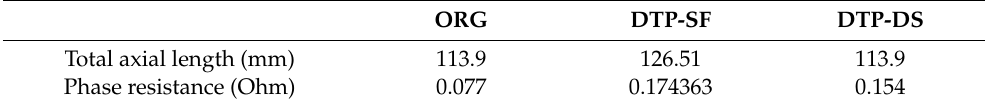
Table 3. Estimated key parameters of different winding